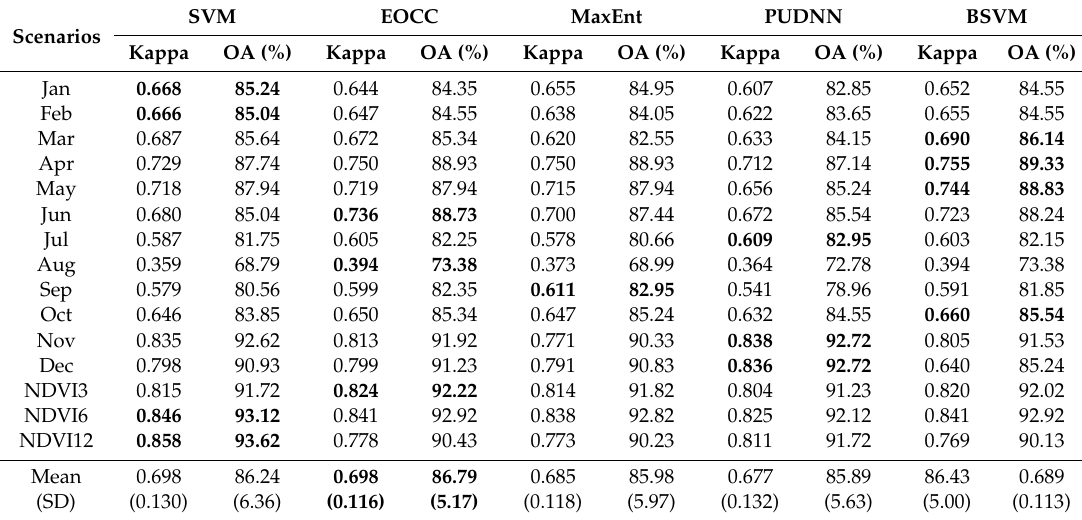
Table A2. Summary statistics for the OA and Kappa of OCC classifiers and the fully supervised classifier SVM in Scenarios 1 and 2. Values in the last row are the mean and standard deviation (SD) of OA and Kappa for the SVM and OCC classifiers in Scenarios 1 and 2. Values in parentheses are standard deviations. The best result for each scenario is bolded.